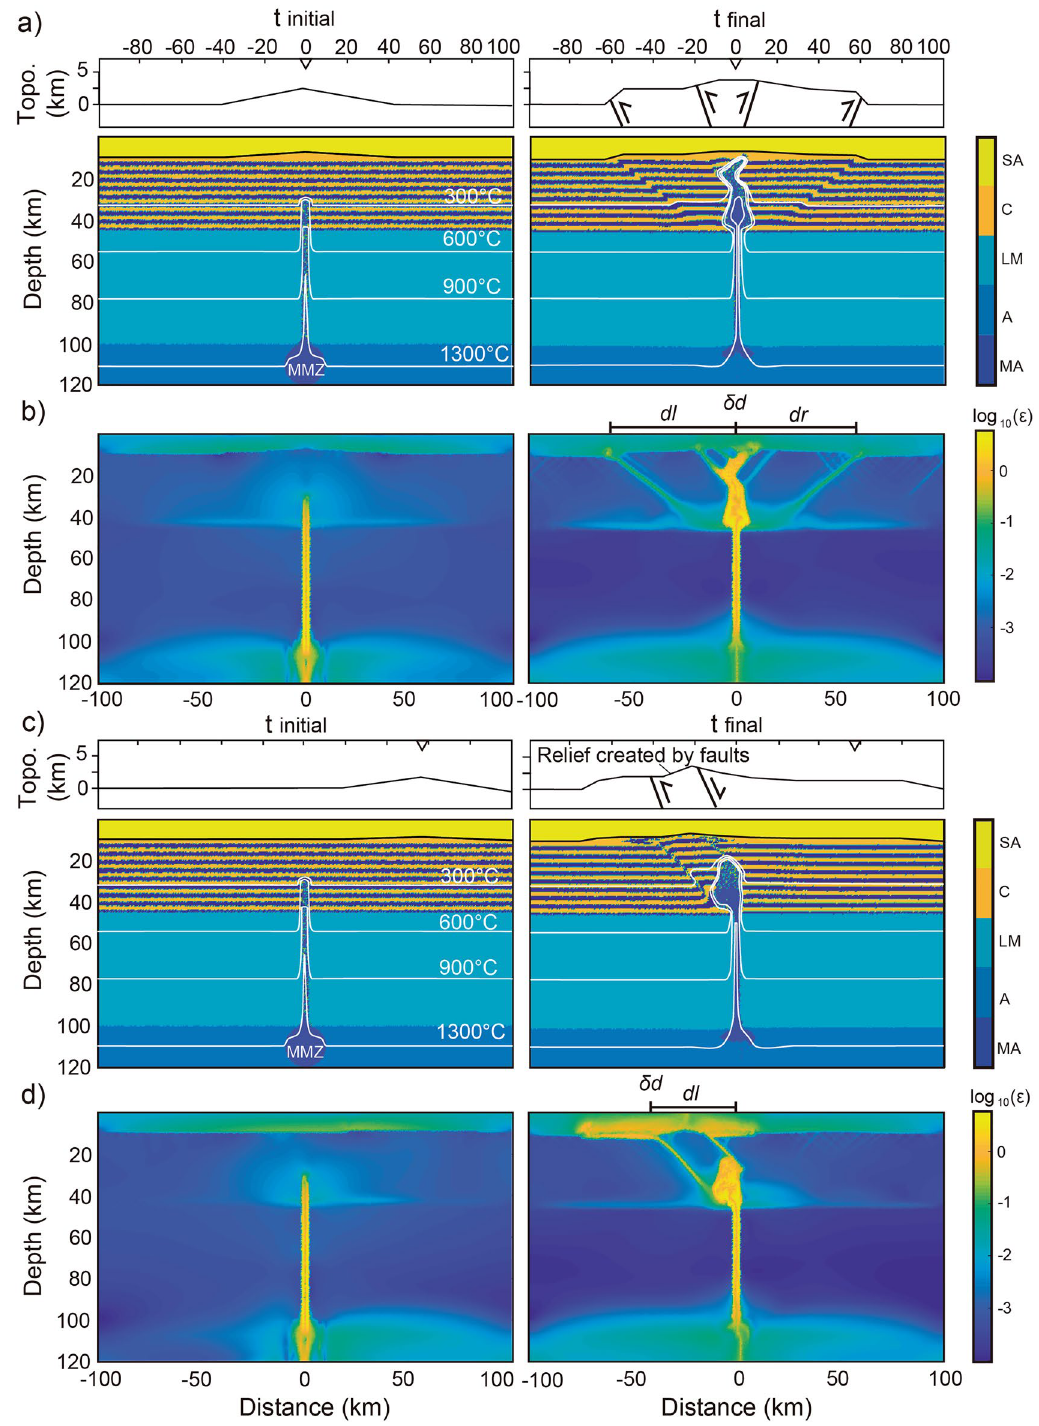
Figure 2. Numerical outcomes of the first set of simulations (Ch = 35 km, Lh = 100 km, Dmc = 20 km). ( a , c ) Initial and final lithologic and thermal distribution of the reference simulations with initial central and lateral topography. The color layering in the crust shows the deformation and the vertical exaggeration of the topographic profiles is 3x. ( b , d ) Initial and final cumulative bulk strain of the same numerical simulations shown in (a, c) . Note the final symmetric system of brittle-ductile structures accommodating the rise of magma to near the surface with initial central topography ( a , b ). Note the final asymmetric system of brittle-ductile structures, leading to left-verging magma ascent with initial lateral (shifted rightward) topography ( c , d ). δ d = dr − dl , where dr and dl are defined in the text. SA—sticky air; C—crust; LM—lithospheric mantle; A— asthenosphere; MA—molten asthenosphere; MMZ: mantle melting